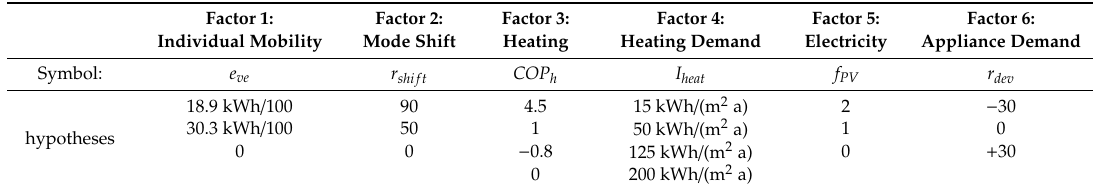
Table 3. Morphological box, supplemented with numerical assumptions (input